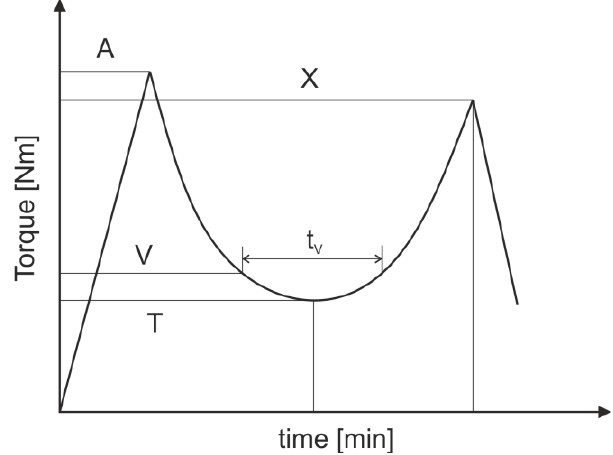
Figure 3. Interpretation of the temperature-dependent flow and hardening behavior measured closely aligned with the German standard DIN 53764 (presently withdrawn) and the recommendations of Brabender GmbH Co. & KG. A: Loading peak, T : Minimum torque, X : Maximum torque after curing, V : Residence torque calculated to B + 10% of the di ff erence between X and B , t V : residence time.